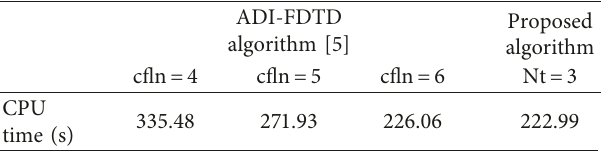
Table 2: Simulation results of the two algorithms in the second